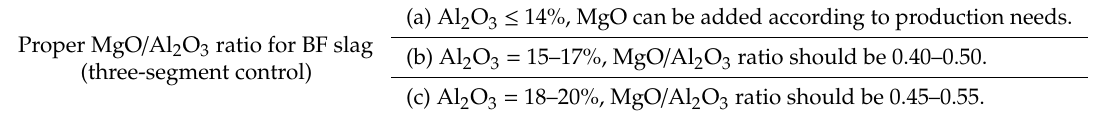
Table 3. Three-segment control theory of the proper MgO / Al 2 O 3 ratio for BF slag (quantitative). Proper MgO / Al 2 O 3 ratio for BF slag (three-segment